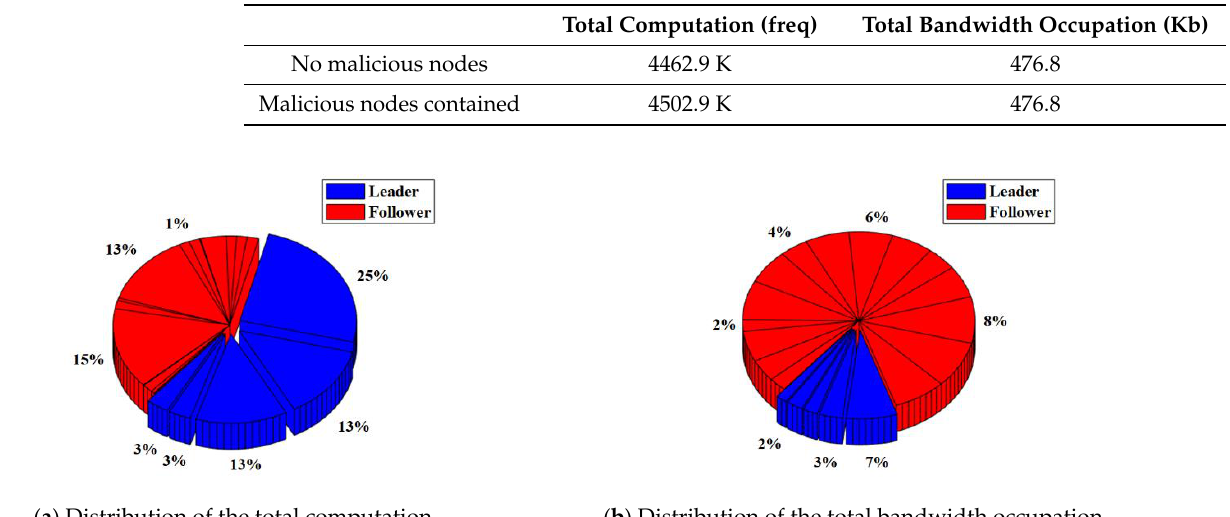
Table 6. The performance of the DPOS algorithm.